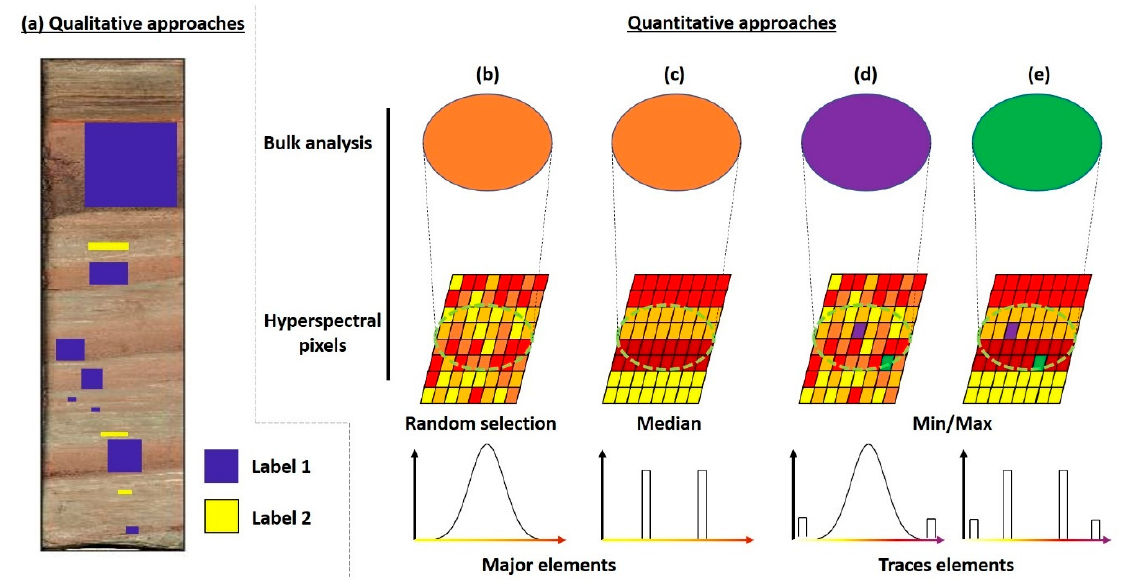
Figure 10. Strategies to subsample the hyperspectral data to create ( a ) a qualitative or ( b – e ) a quantitative predictive model (figures adapted from [49,124]).